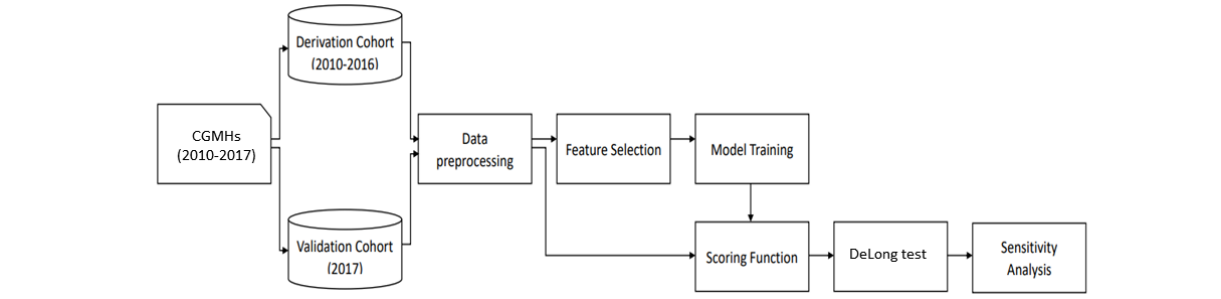
Figure 1. Flowchart for prediction and risk scoring. CGMHs: Chang Gung Memorial